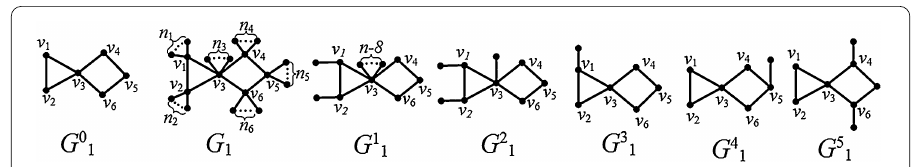
Figure 3 Some bicyclic graphs with ∞ (3,4,0) as their